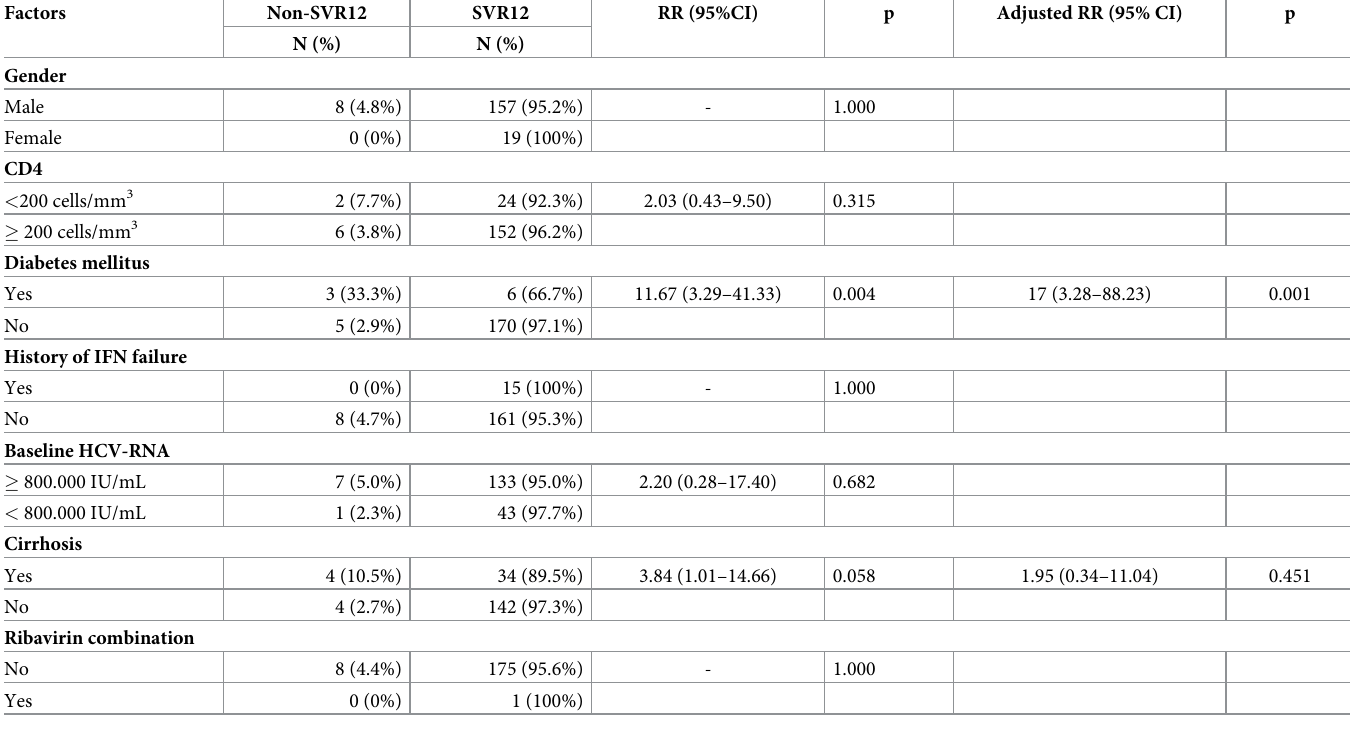
Table 2. In multivariate analysis, the presence of cirrhosis could not predict treatment failure, although it was significant in univariate analysis. In this study, nine patients had been diag- nosed with diabetes mellitus before starting SOF-DCV treatment. One-third of these 9 patients did not achieve SVR12, showing that. patients with diabetes mellitus had a 17 times higher treatment failure rate (95% CI 3.28–88.23). A study by Patel, et al supported this finding. In that study, diabetes mellitus was negatively associated with achieving SVR12 (OR 0.68, 95% CI feron era showed that insulin resistance, the driving factor that leads to type 2 diabetes, was a negative predictor for achieving SVR12 (OR 0.44, 95% CI 0.20–0.97) [31]. For those who did not achieve SVR12, testing for HCV genotype might be needed for future treatment options. In the original phase III ALLY-3 study, a much lower SVR12 rate was observed in genotype 3-infected patients with cirrhosis treated with SOF-DCV for 12 weeks [28]. The addition of RBV to SOF-DCV was recommended to improve the SVR12 response in genotype 3 infected patients with cirrhosis [32, 33]. Our previous study in 2014 showed that genotype 3 is the second most common HCV (21.9%) genotype in HIV/HCV co-infected patients after genotype 1 (68.6%) [34]. Table 2. Results from univariable and multivariable logistic regression models to identify independent factors correlated with sofosbuvir and daclatasvir treatment failure (n = 184).